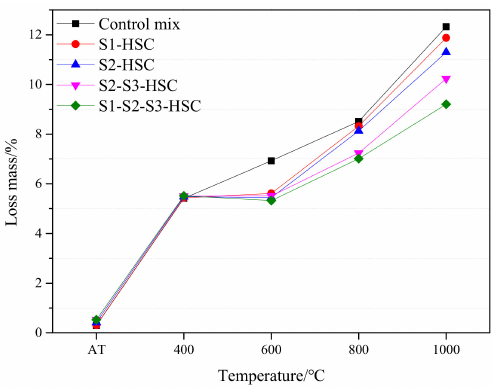
Figure 8. Loss mass of the specimens subjected to elevated